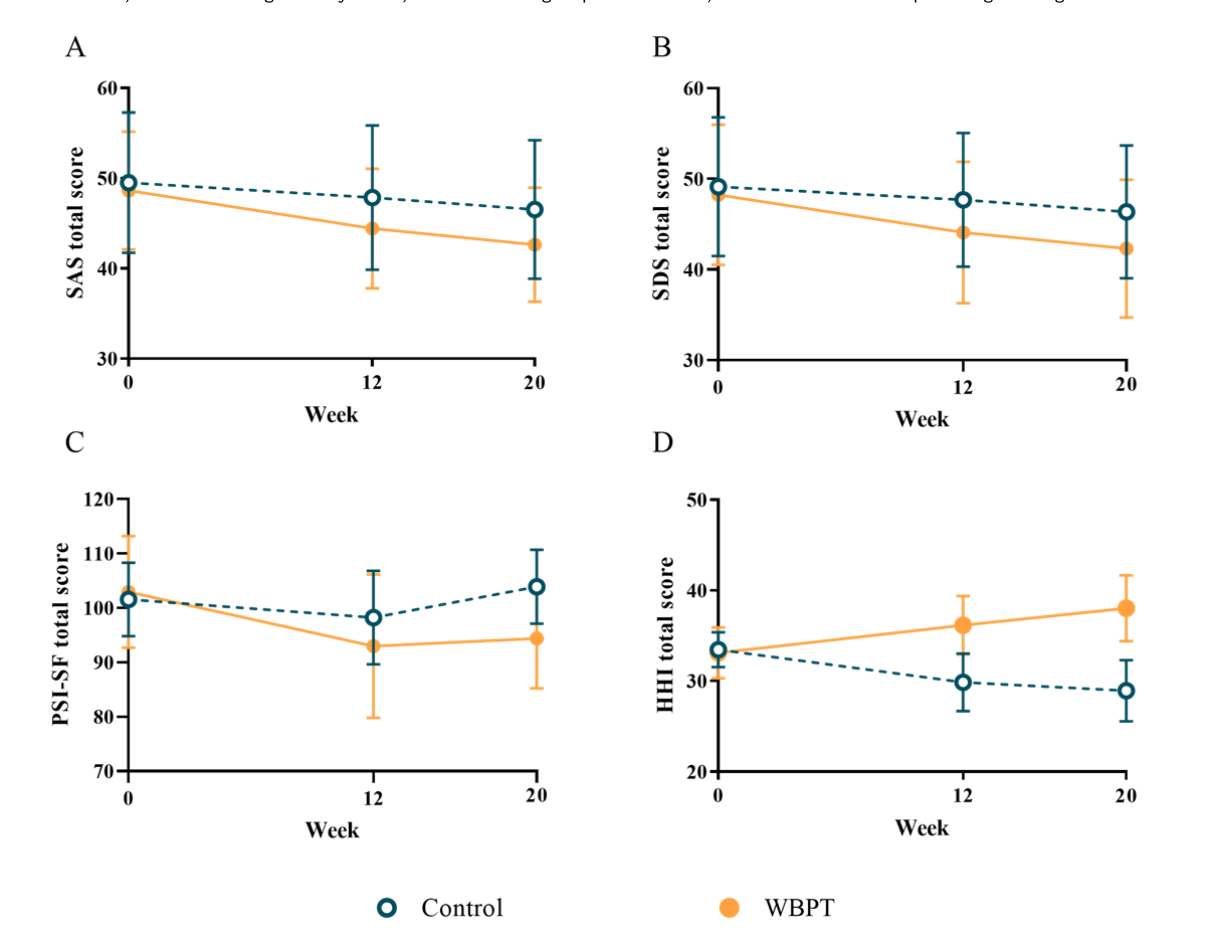
Figure 2. Means and 95% CIs for SAS, SDS, PSI-SF, and HHI scores from baseline to follow-up. HHI: Herth Hope Index; PSI-SF: Parenting